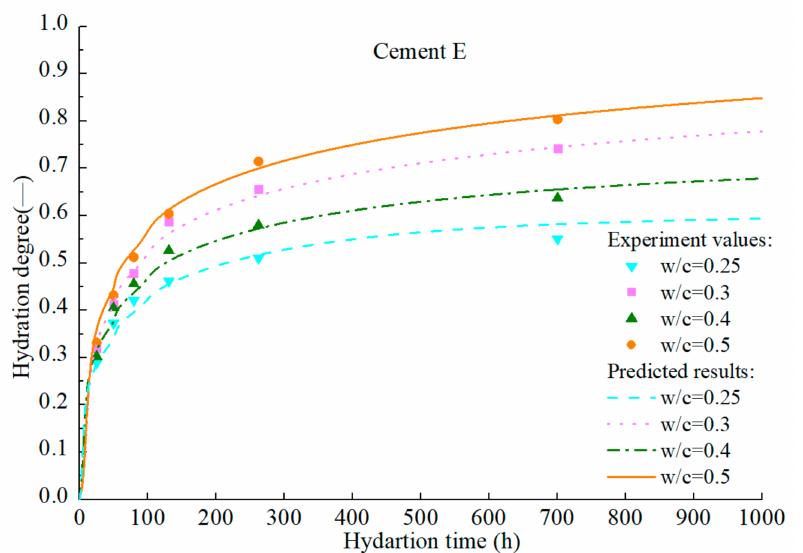
Figure 26. Measured and predicted hydration degree of cement H with different water–cement